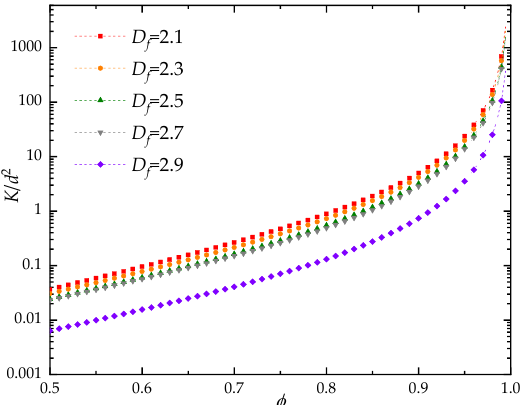
Figure 7. The relationship between fractal dimension and porosity: ( a ) pore fractal dimension; ( b ) tortuosity fractal dimension.